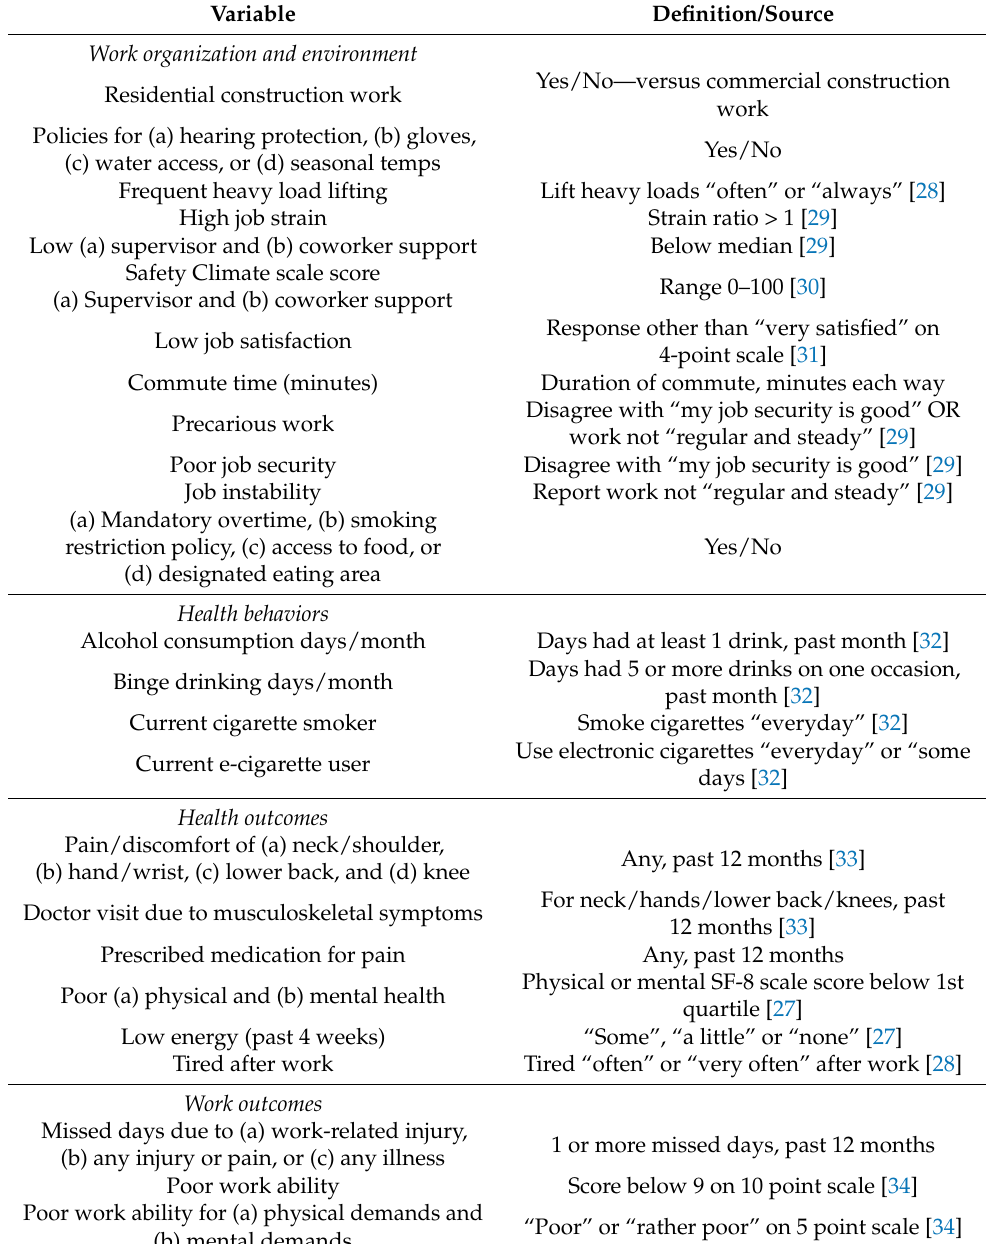
Table 1. Definitions and sources of work outcome, health outcome, health behavior, and work factor